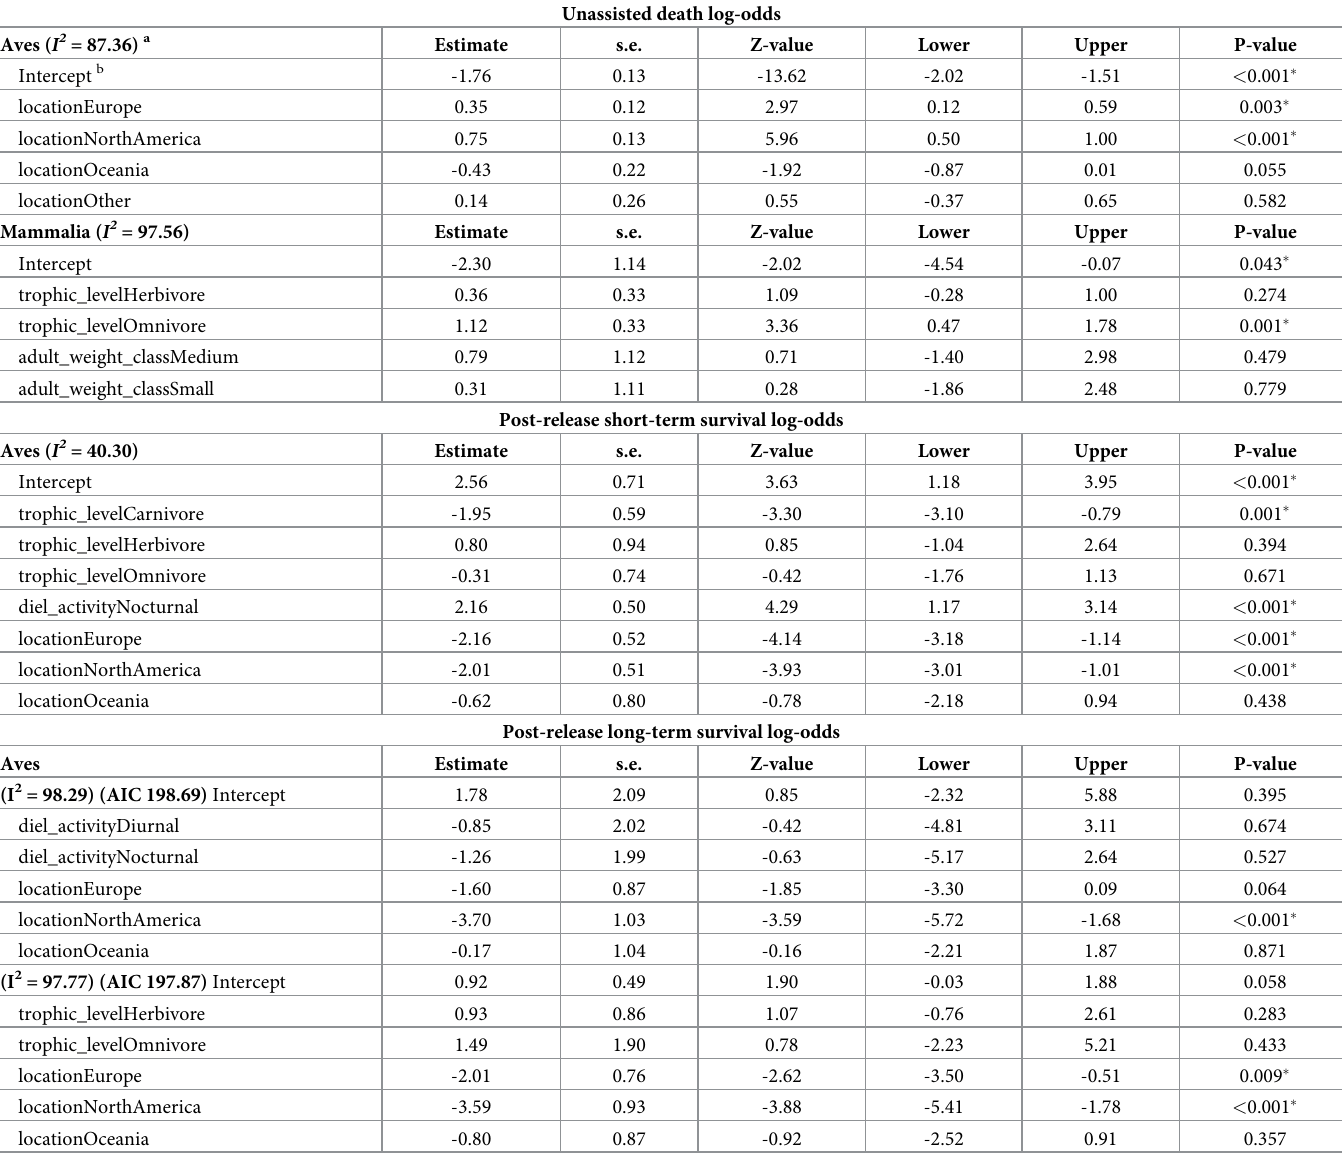
Table 3. Summary of mixed-effects meta-regression models with the best fit and significant predictors of survival for bird and mammal classes for each survival stage.